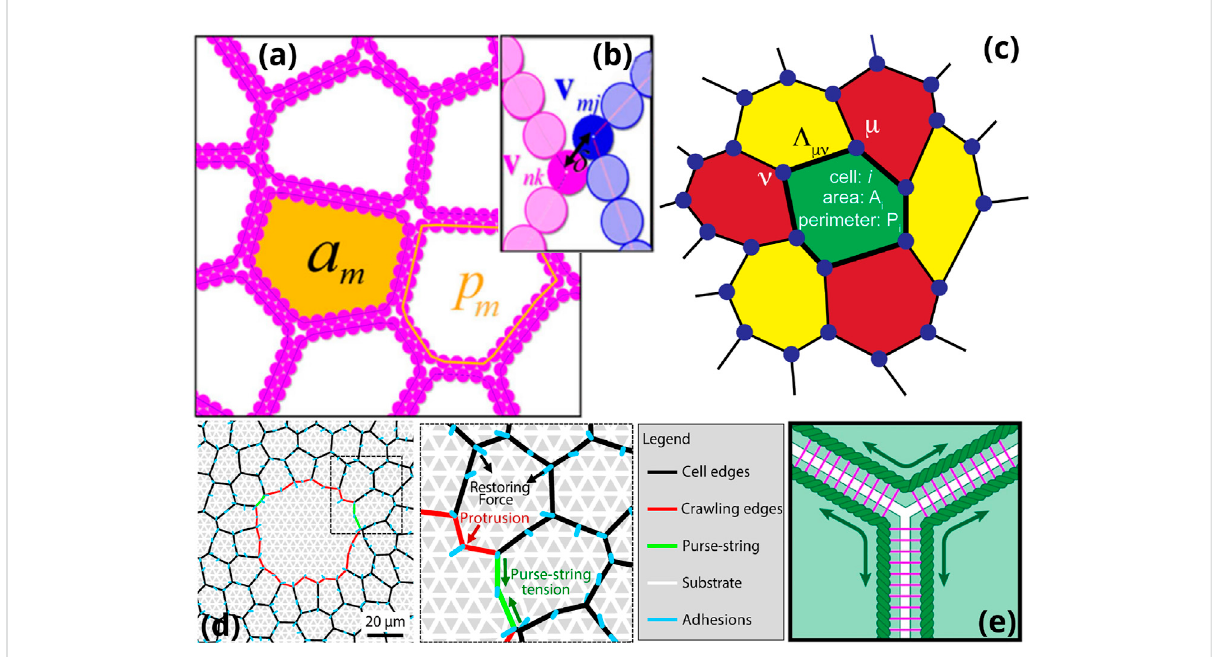
FIGURE 5 Theoretical descriptions of biological tissues (A,B) Deformable polygons or deformable particles model: each polygon is de fi ned by its area a and perimeter p . The perimeter is dividedin N = 34 vertices whosepositionsare determined by different energetic contributions:one that takes into accounts springs between each vertex on a polygon, a compressibility term, a line tension term, a bending energy term for the contour of the polygon,andarepulsivetermpreventingoverlapsbetweenadjacent polygons[136]. (C) Schematicrepresentationofthevertexmodelinwhich each cell i of the space tiling is de fi ned by a target area A i and perimeter P i of reference. Three (or more) edges of neighboring cells meet at vertices and each junction between two vertices has a line tension [138]. (D) Application of an active vertex model to wound healing. Protrusive forces and adhesion tothesubstrate areaddedto thevertexmodelforwoundclosure [139]. (E) Apposed-cortexadhesionmodel:inthisextensionofthevertex model the cortices of neighboring cells (dark green) are explicitly coupled through adhesion molecules (pink), allowing for continuous rearrangements in the tissue through slippage